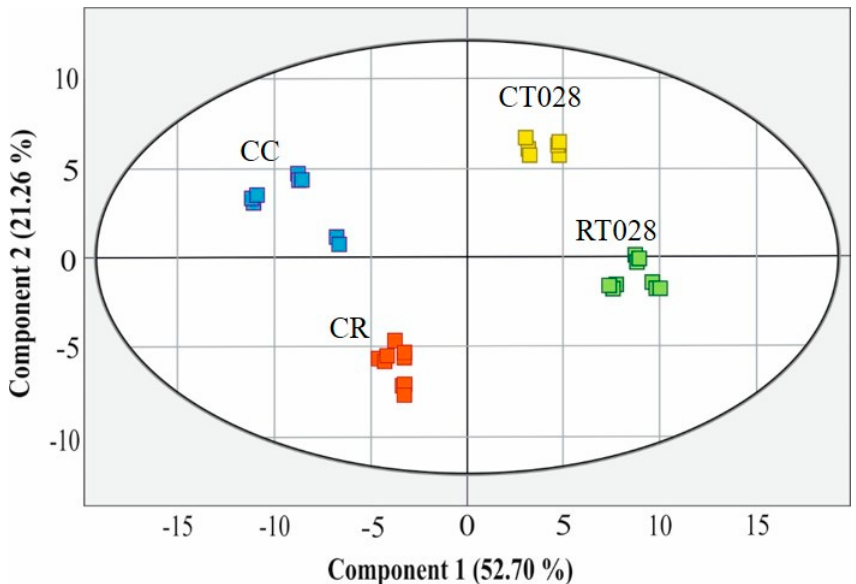
Figure 4. Principal components analysis of 36 compounds extracted from bean leaves subjected to different treatments. (Blue) control beans without pathogen and biocontrol agent (CC); (Red) beans that were infected with R. solani (CR); (Yellow) beans inoculated with T. velutinum (CT028); (Green) beans inoculated with R. solani and T. velutinum (RT028).